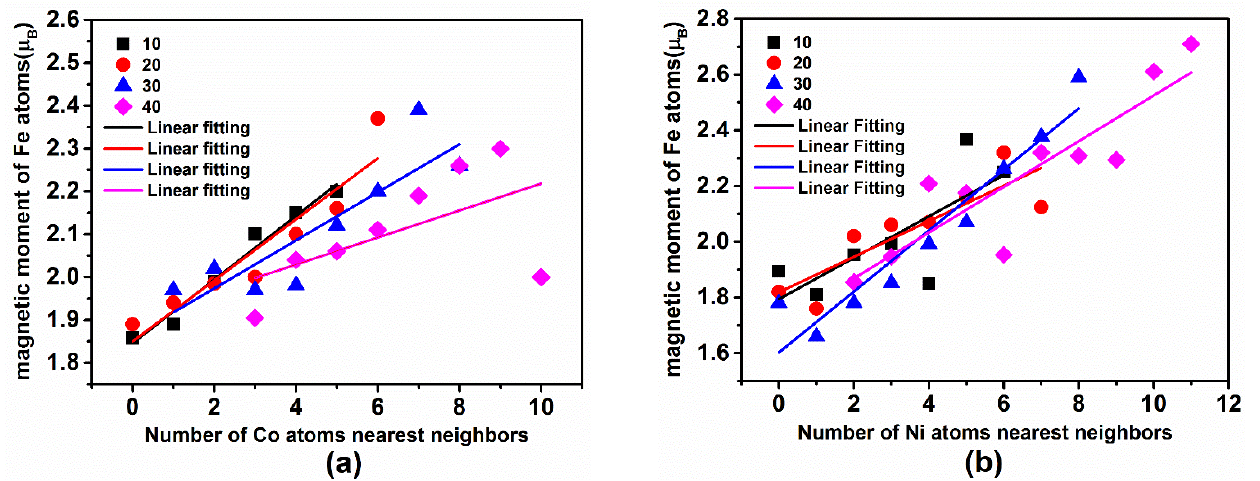
Figure 6. Magnetic moment of Fe atoms for different numbers of Co or Ni nearest neighbors in ( a ) Fe 80 − x Co x B 20 or ( b ) Fe 80 − x Ni x B 20 (x = 10, 20, 30, and 40 at.%) amorphous alloys. Solid lines in different colors indicate linear fitting curve.